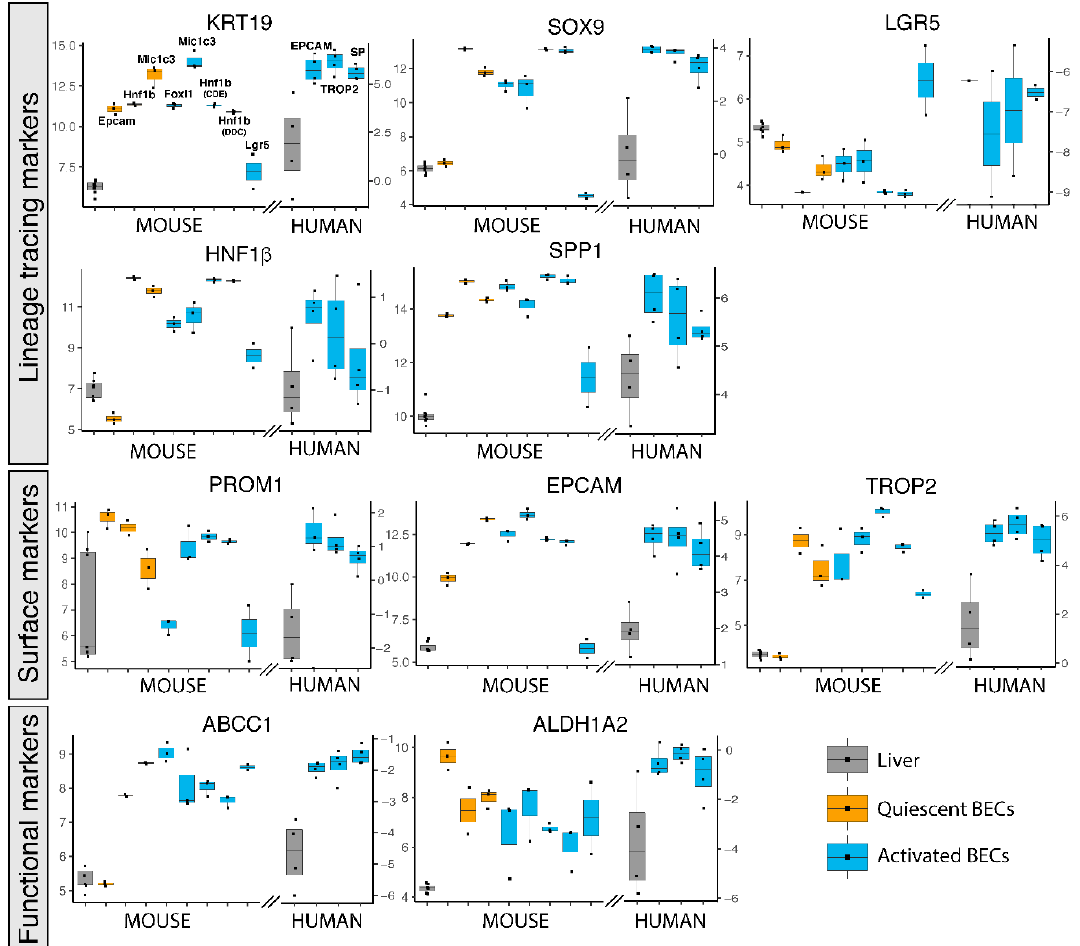
Figure 2. Gene expression of popularly used BEC markers for isolation in primary human and mouse BECs. Gene expression of mouse and human livers (grey), quiescent (orange) and activated (blue) BECs. Left axis represents normalized intensity values (log2) for all mouse gene expression and right axis normalized transcript per million (log2) for human data.